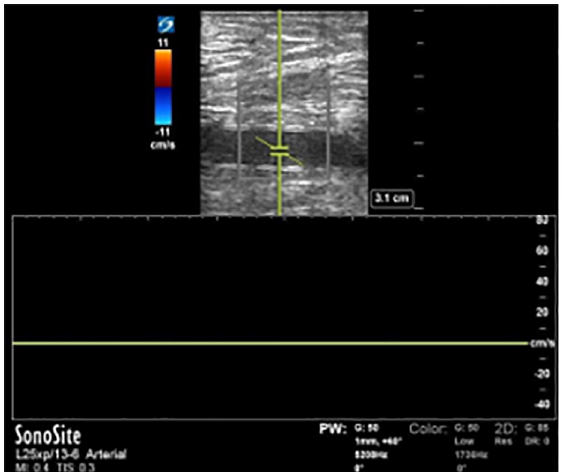
Image 5b. Color Doppler and pulsed-wave Doppler show no flow in this segment of thrombosed graft.